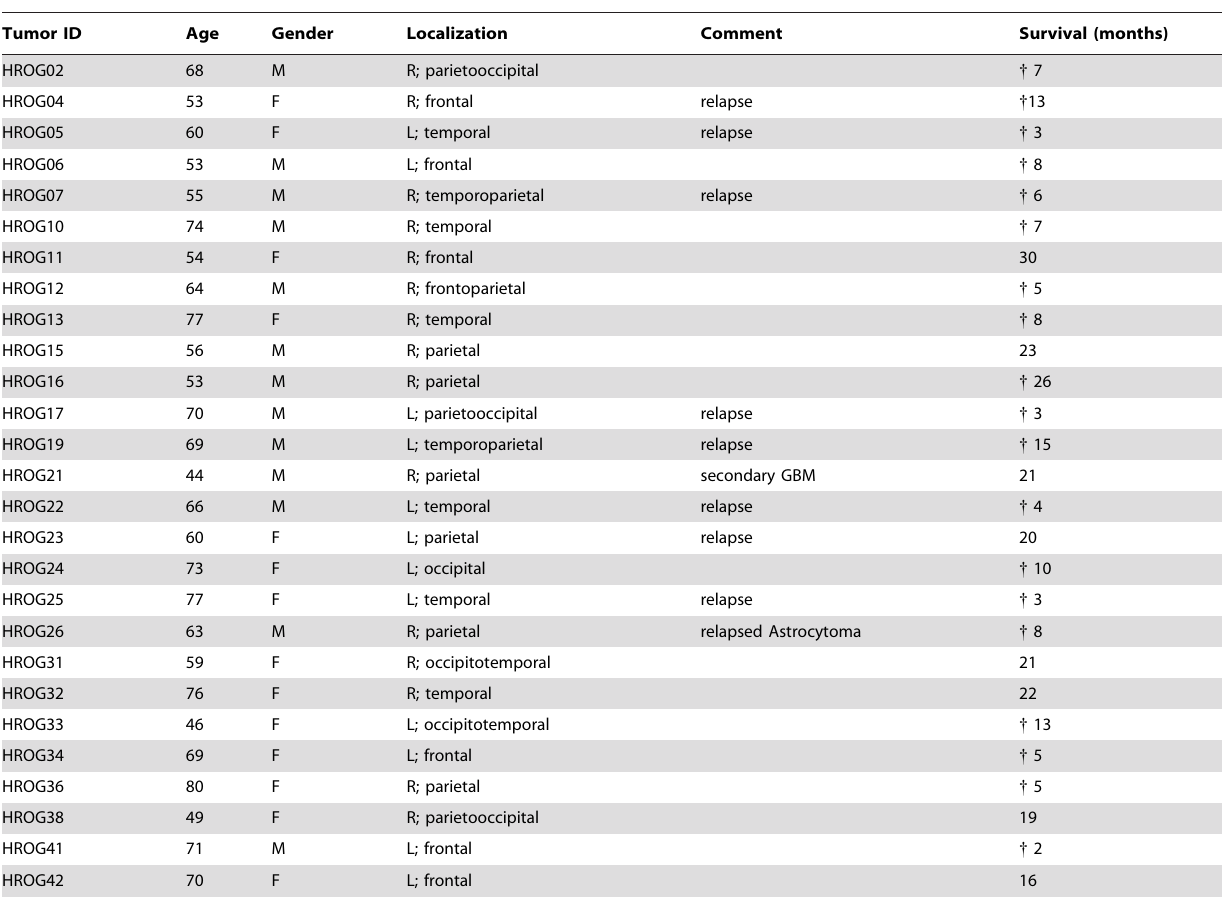
Table 1. Clinical